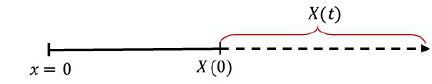
Figure 1. The one-dimensional region of drug